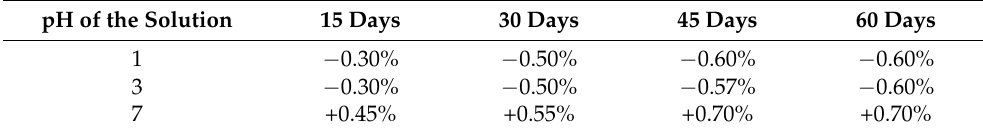
Table 3. Chemical stability (weight of the foam glass samples) after days of immersion in sulfuric acid (pH = 1 and pH = 3) and deionized water (pH = 7). “+“ Denotes weight increase and “ − “ denotes weight decrease.